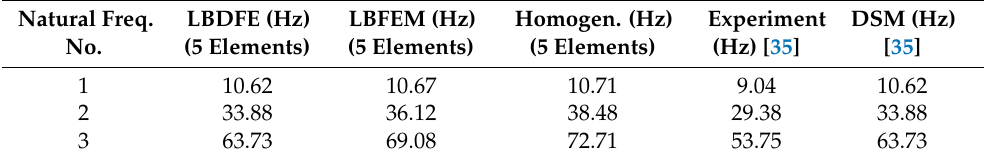
Table 1. Comparison between experimental results [35], DSM [35], LBDFE, LBFEM and homogeniza- tion methods with P = 0 and M zz = 0 with cantilevered boundary condition. Natural Freq.